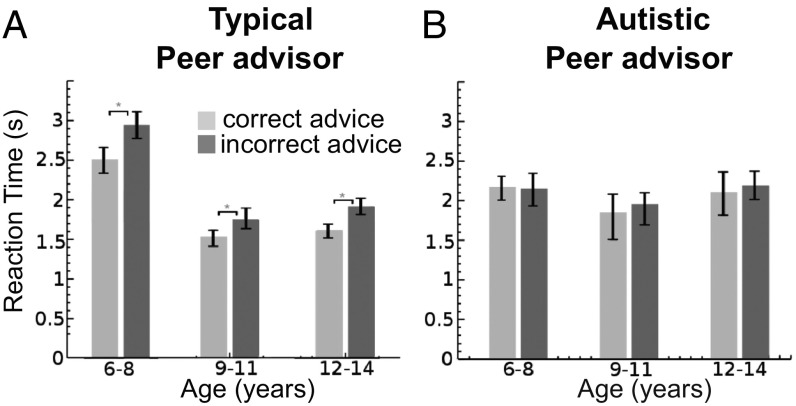
RTs for conforming with peer social influence for matched neurotypical and autistic children. (A) Median RTs for conforming decisions of neurotypical children were significantly faster when social influence direction was correct rather than incorrect. *P < 0.05, Wilcoxon rank sum, Bonferroni corrected; error bars show 95% confidence intervals. Advisor type did not have a significant effect on RT [ANOVA; F(1,165) = 2.91, P = 0.086]. (B) For autistic children, there was no significant difference in median RTs for conforming to correct or incorrect peer advice. Overall, an autism diagnosis did have a significant effect on RTs [ANOVA; F(1,165) = 4.97, P = 0.027]. For detailed RT distributions, see SI Appendix, Fig. S2.